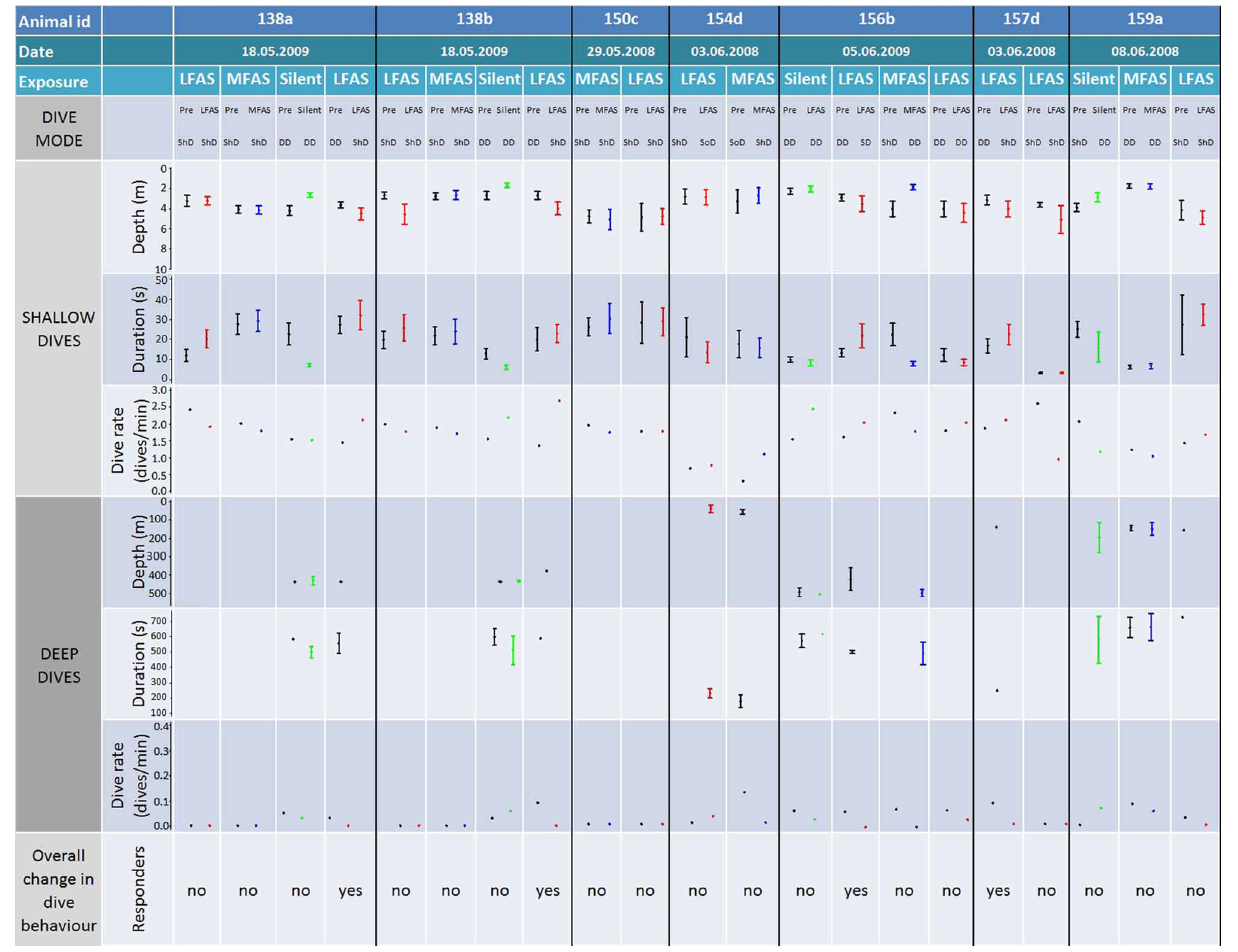
FIGURE 6 | Comparison of individual exposures to long-finned pilot whales. Figure shows animal id, exposure type, dive mode (during PRE and Exposure), as well as dive depth, duration, and rate for both shallow and deep dives. Log frequency analysis defined deep and shallow dives to be deeper and shallower than 34m respectively for killer whales. Codes for dive modes are: deep diving (DD), shallow diving (ShD) and shallow diving with occasional